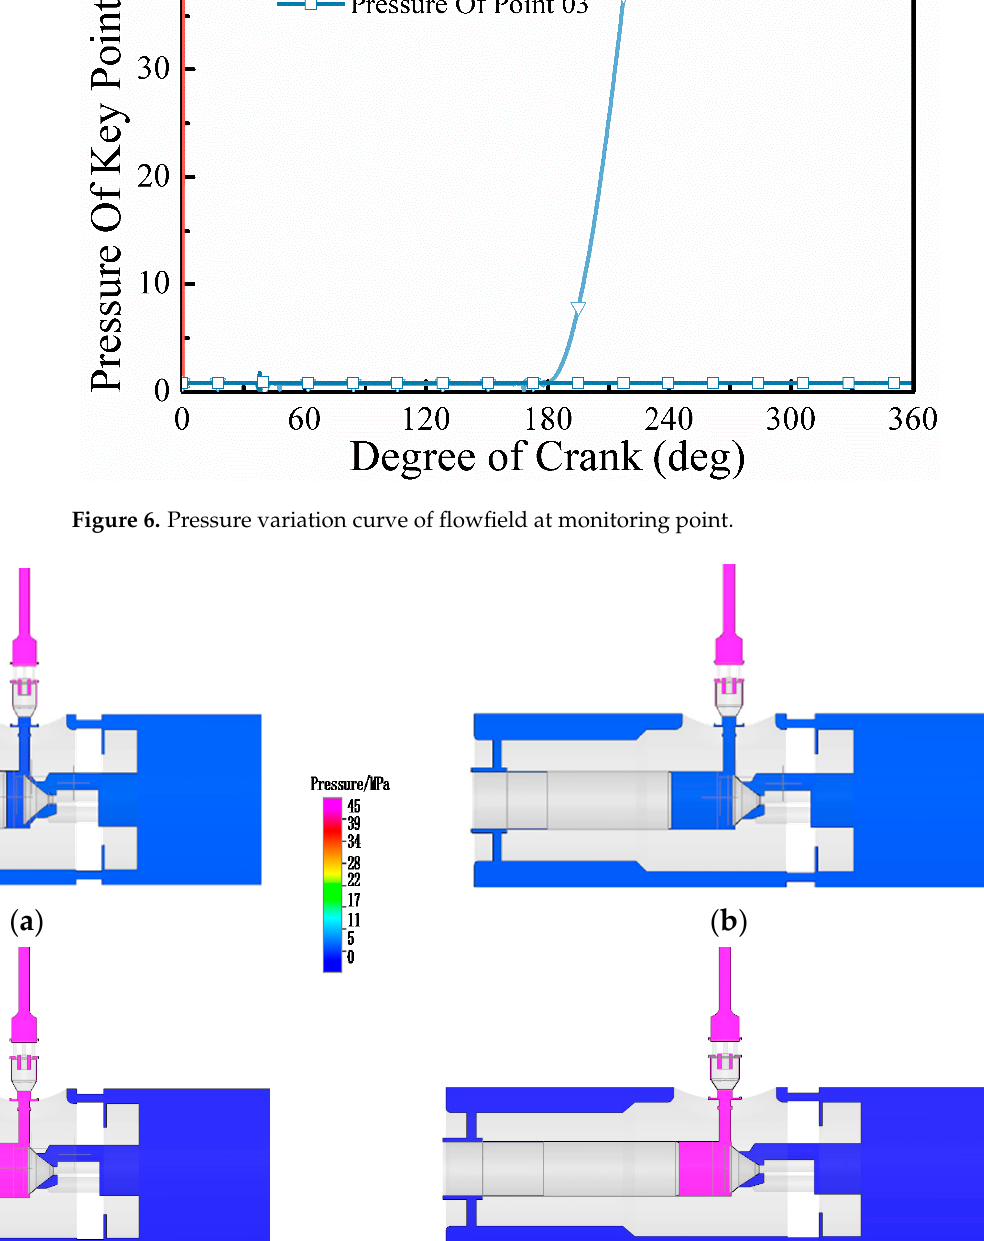
Figure 6. Pressure variation curve of flowfield at monitoring point.